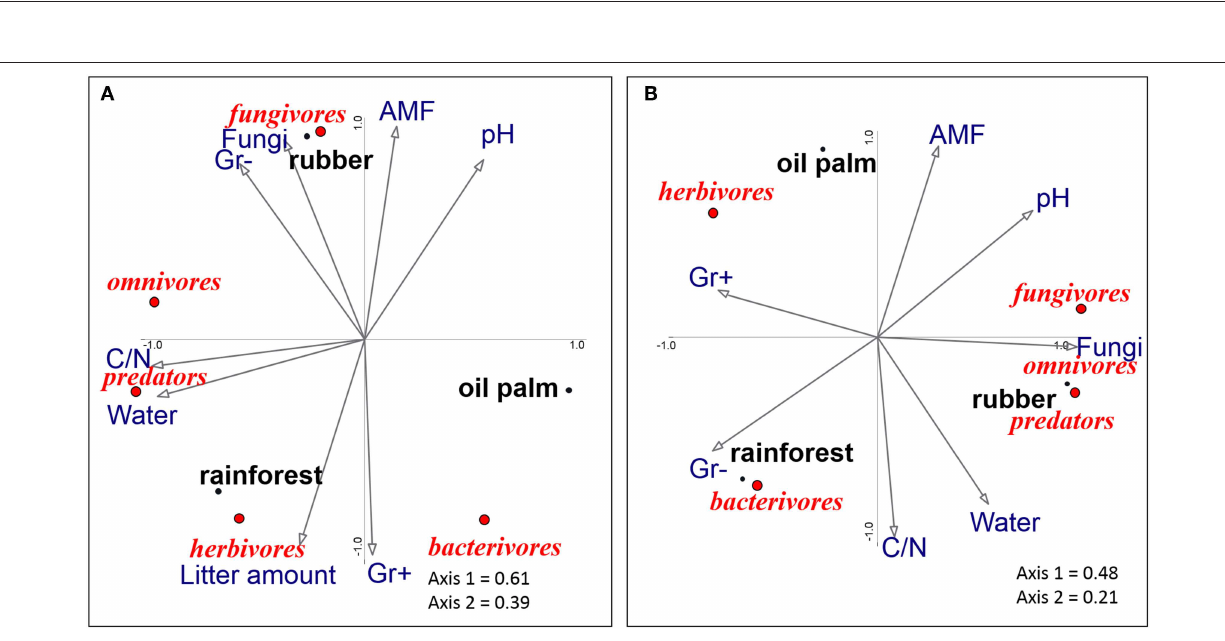
FIGURE 2 | Principal components analysis of nematode trophic groups (fungivores, omnivores, predators, herbivores, and bacterivores) in litter (A) and soil (B) as related to environmental variables (arrows) of three land-use systems (rainforest, rubber, and oil palm plantations). The position of trophic groups is represented by centroids; n = 12. C/N, carbon-to-nitrogen ratio, pH, pH-value; Water, water content; Gr + and G–, Gram-positive and Gram-negative bacterial phospholipid fatty acids (PLFAs); Fungi, fungal PLFA (18:2 ω 6,9); AMF, relative marker of arbuscular mycorrhizal fungal neutral lipid (NLFA, 16:1 ω 5); for the environmental data, see Supplementary Table 3